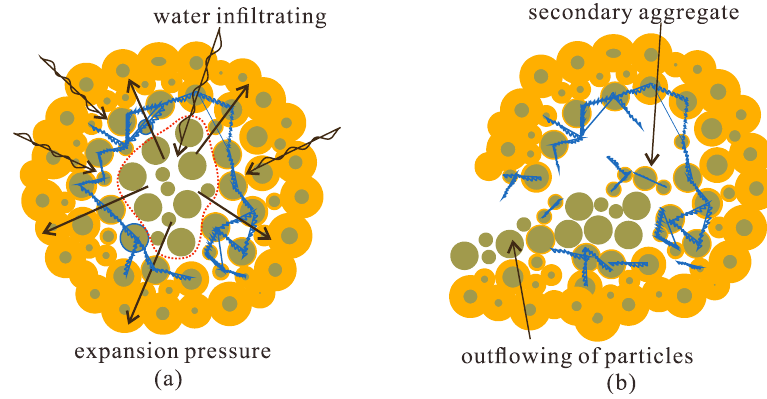
Figure 12. Illustration of the mechanism of water stability of the aggregates: ( a ) inner expansion pressure generated; ( b ) stabilized shell ruptured by the inner expansion pressure.